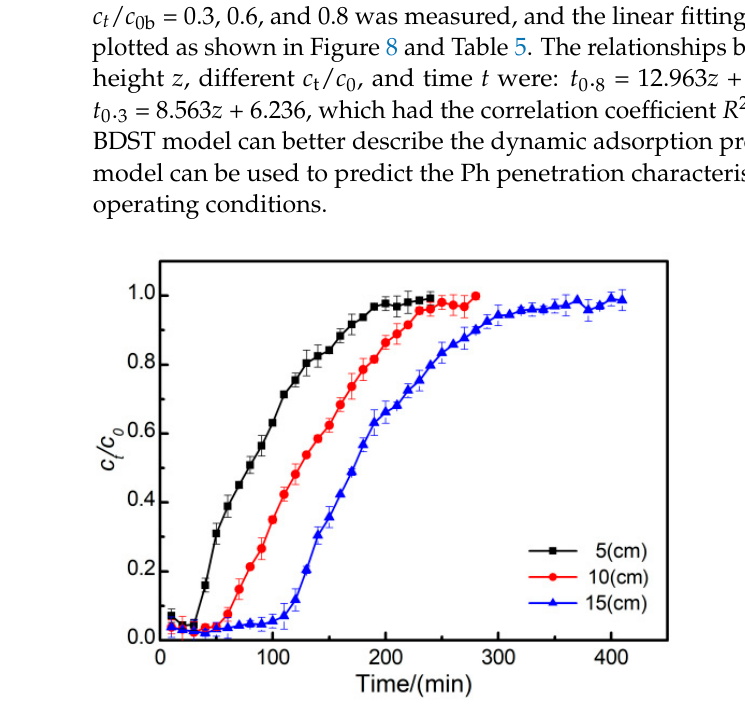
Figure 8. Fitting curves in the BDST model. Table 5. BDST parameters for different conditions.